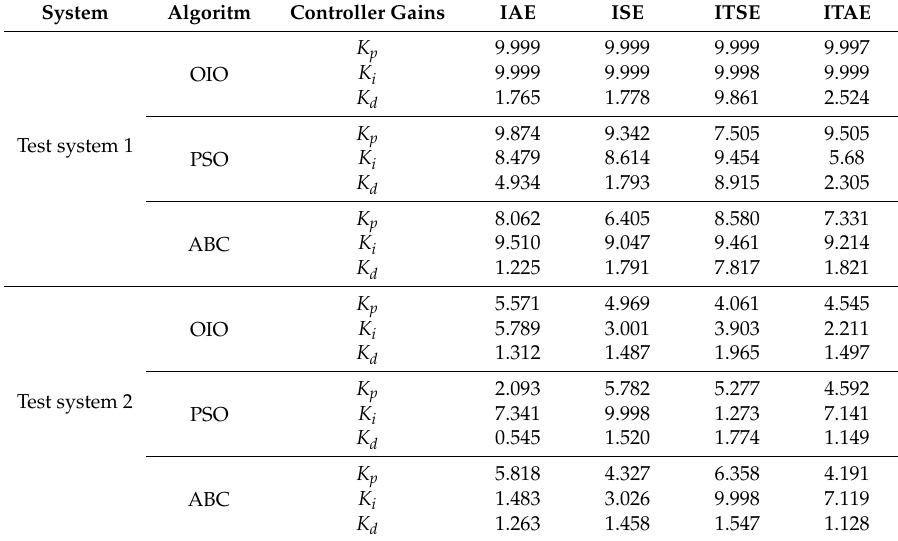
Table 2. Optimal parameters of the PID controllers for test system-1 and test